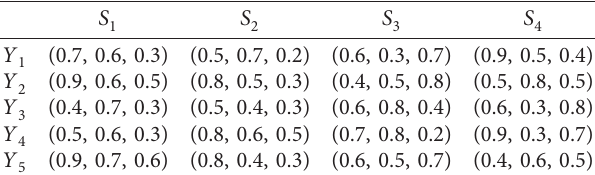
Table 1: 3F decision matrix.